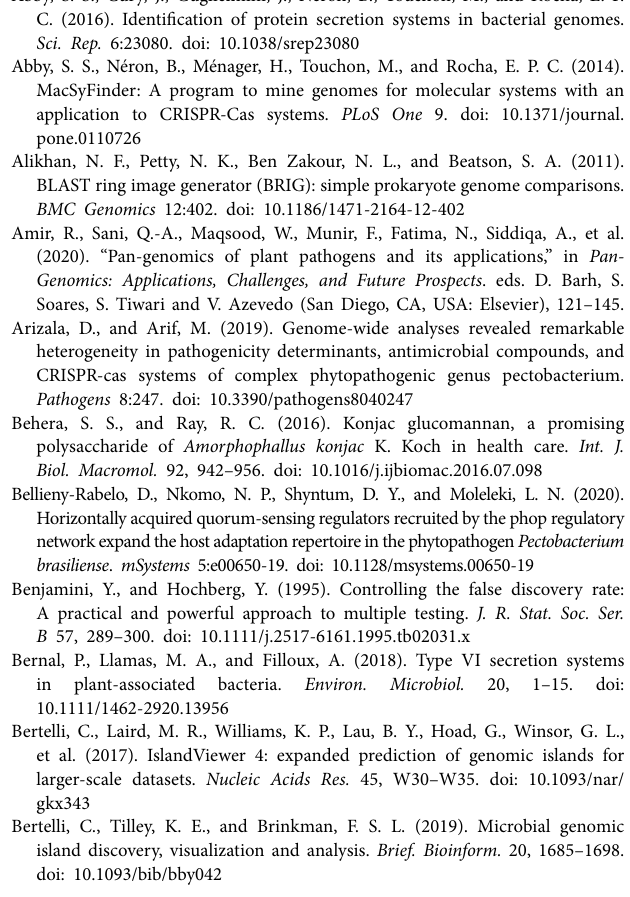
Supplementary Figure 1 | Pathogenicity tests of other bacterial isolates on konjac slice tuber. Supplementary Figure 2 | The formation of pits caused by other bacterial isolates on CVP medium. Supplementary Figure 3 | BUSCO assessment results of the 11 P . aroidearum assemblies. Supplementary Figure 4 | Genome comparison of the 11 bacterial isolates using P . aroidearum QJ002 as the reference by the BLAST Ring Image Generator (BRIG). Supplementary Figure 5 | Pangenome analysis of 64 Pectobacterium strains using the Roary pipeline. (A) A pie chart displays the proportion of genes in the core, shell, and cloud of the pangenome. (B) The size of the core genome and pangenome with the increasing numbers of Pectobacterium genomes.